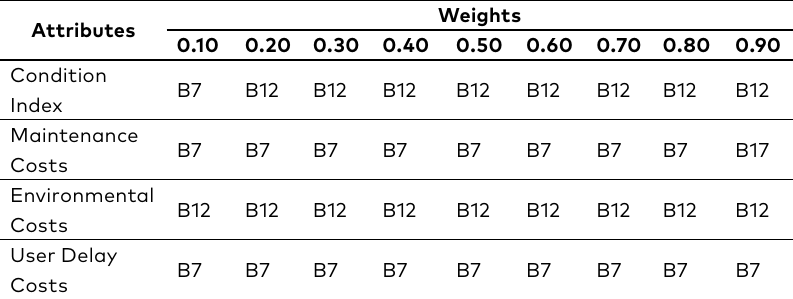
Table 2. Single-attribute sensitivity analysis for each